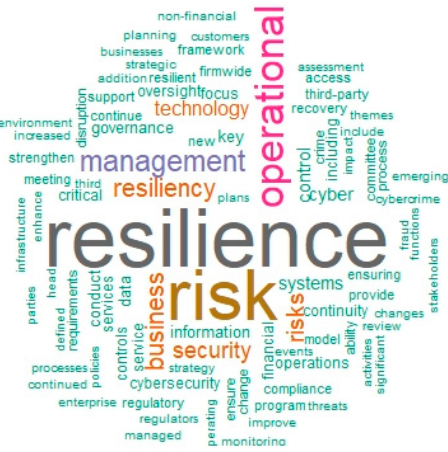
Figure 5. Word cloud for the text around operational resilience.